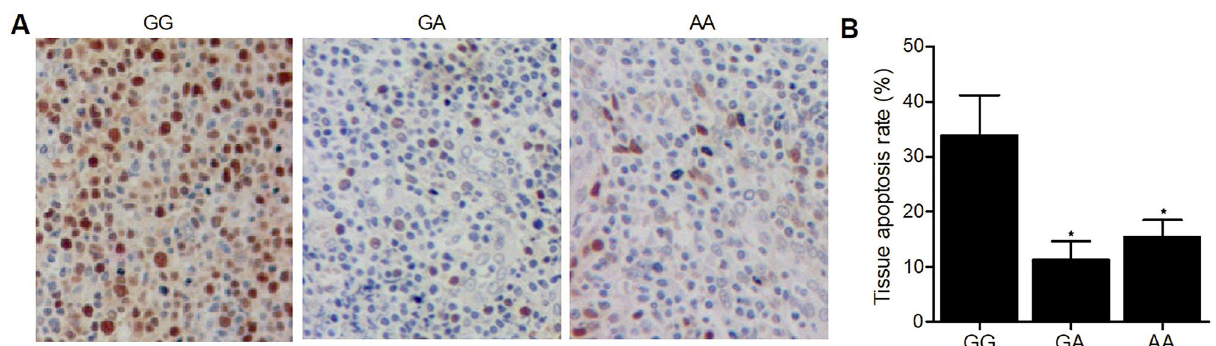
Figure 4. TUNEL analysis showed that GG polymorphism at rs4911154 was correlated with an increased apoptosis rate in the tissue samples of thyroid nodule patients (*P value < 0.05 vs. GG